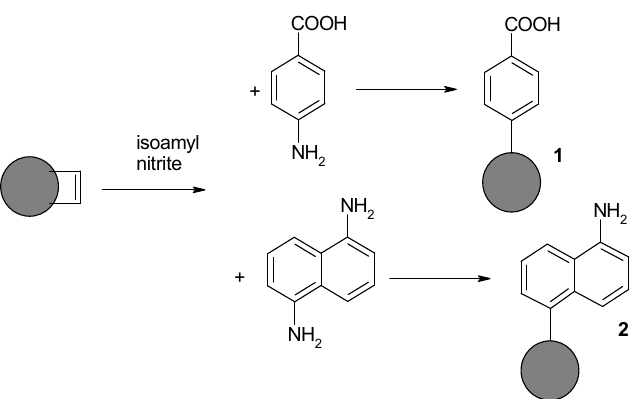
Figure 3. Synthesis of modified NDPs containing residues of benzoic acid and naphthylamine.